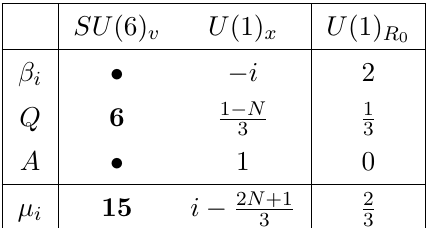
under the global A